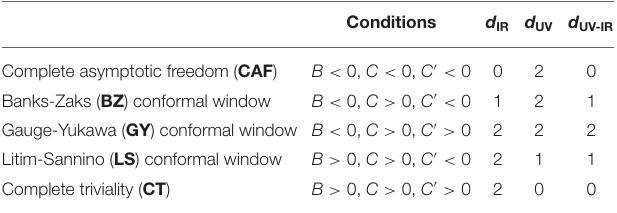
TABLE 1 | Different perturbative Renormalization Group phases for simple gauge-Yukawa